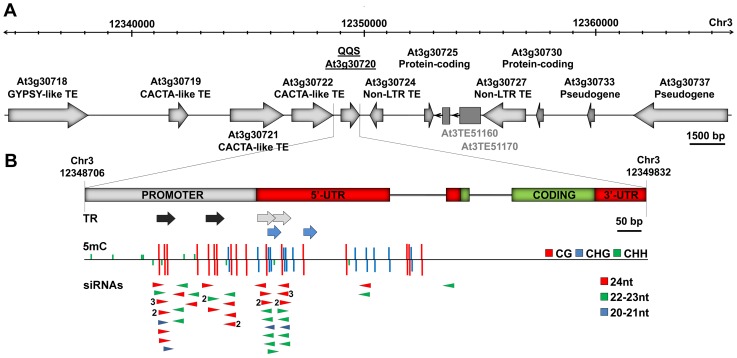

QQS is embedded in a repeat-rich region.(A) Genomic structure of the QQS locus (30 kb window) in the Col-0 accession. Dark grey boxes represent two additional TE sequences predicted by [51], [52]. (B) Magnified view of the QQS gene and upstream sequences, showing tandem repeats (TR), methylation of cytosine residues (5 mC) at the three types of sites (CG, CHG and CHH, H = A, T or C) and locus-specific sense and antisense siRNAs (numbers referring to copy number). DNA methylation and siRNA data are from [25].